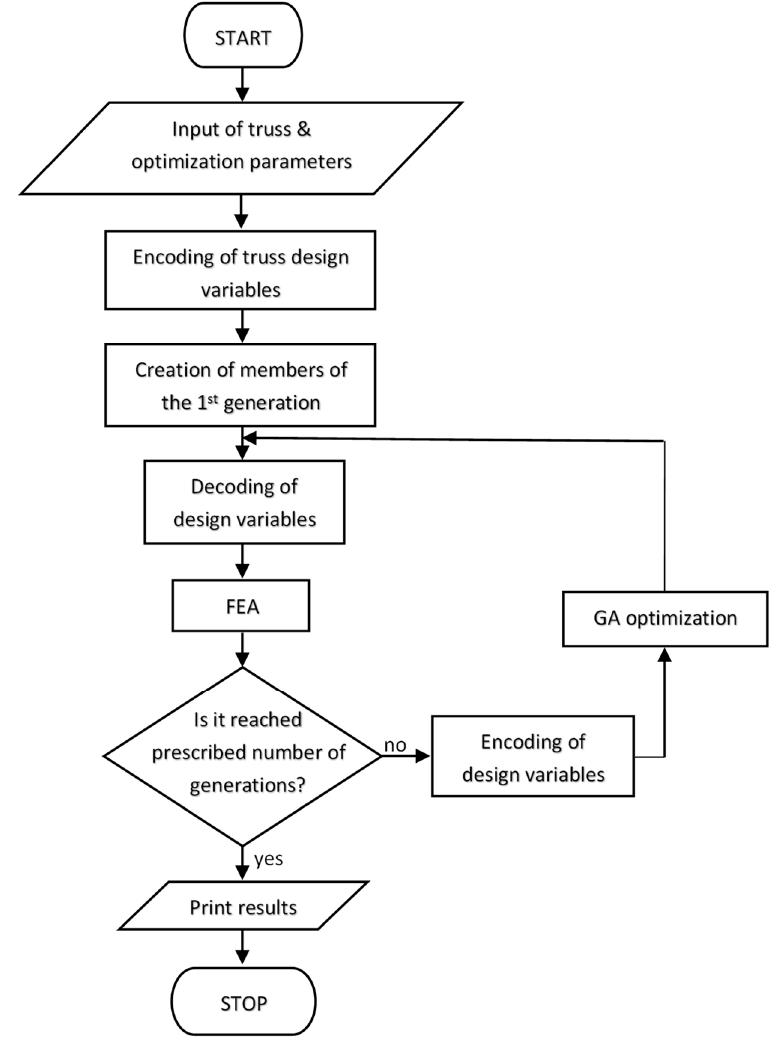
Figure 1. The flow chart of the optimization process (GA—genetic algorithm, FEA—finite element analysis).